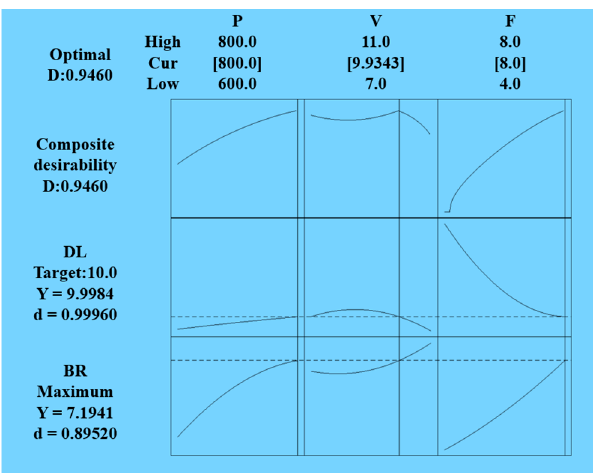
Figure 11. Desirability plot of BR and DL. Table 7. Optimization results of the model .